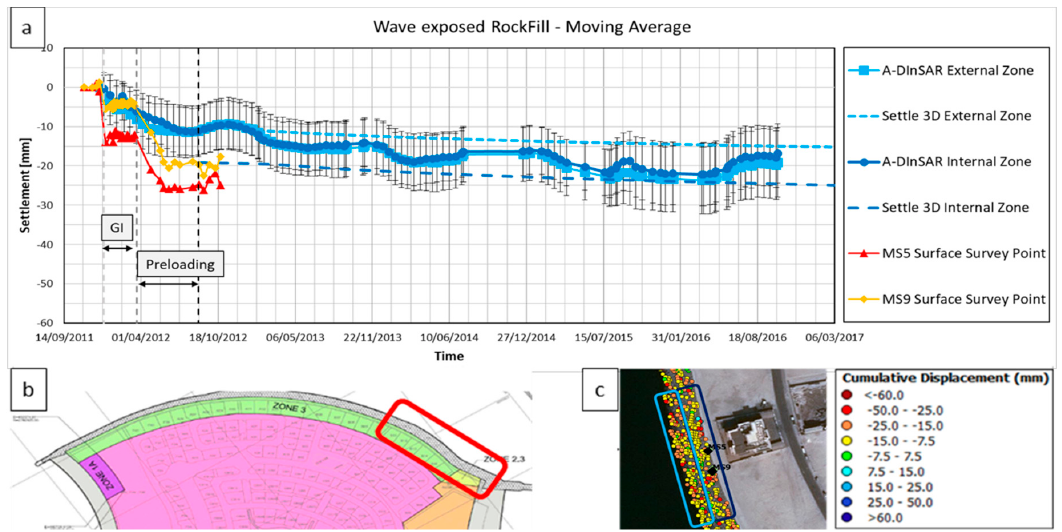
Figure 17. ( a ) Diagram showing the data integration in wave-exposed rockfill revetment area including the vertical component of A-DInSAR time series of displacement in dark and light blue, Settle 3D creep in dark and light blue dashed line and field monitoring data in red and yellow. Black and grey dashed vertical lines show the working phases. GI stands for ground improvement. ( b ) Location of the data showed in ( a ). ( c ) A-DInSAR derived MPs (red, orange and yellow dots) and field monitoring data (black dots). Light and dark blue boxes show the external and internal zone, respectively.